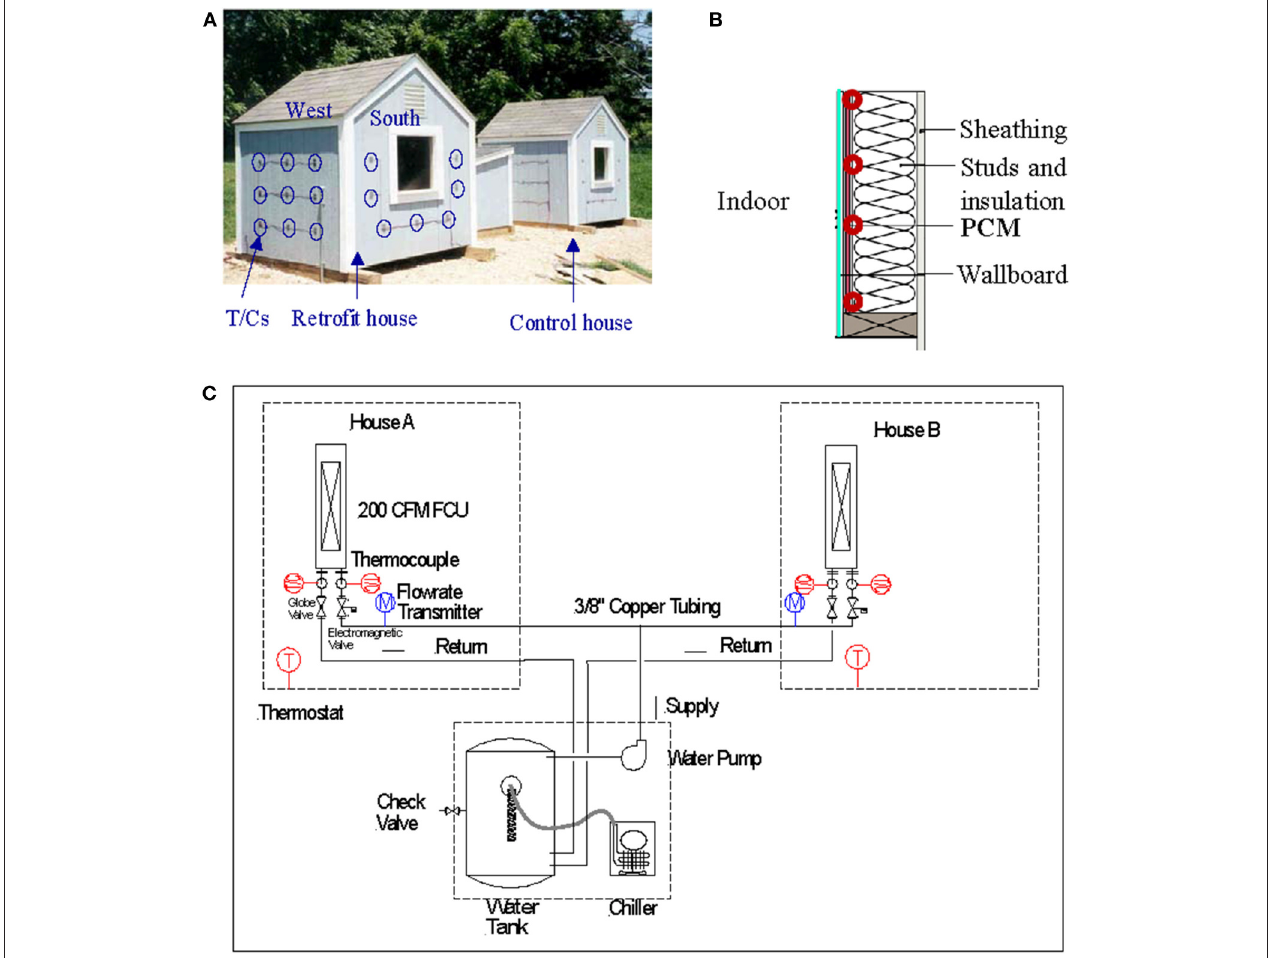
FIGURE 2 | Control and experimental test houses. (A) Pictures of the test houses. (B) Wall assemblies. (C) Space cooling system.